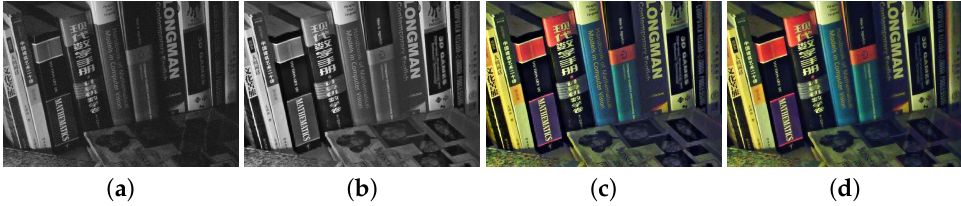
Figure 7. Fusion and color enhancement results in Books . ( a ) Original gray image. ( b ) Fusion results in the luma channel. ( c ) Inverse color space conversion (YCbCr → RGB). ( d ) Color enhancement